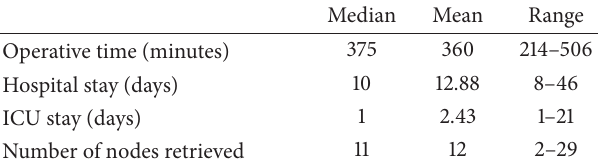
Table 3: Continuous variables.